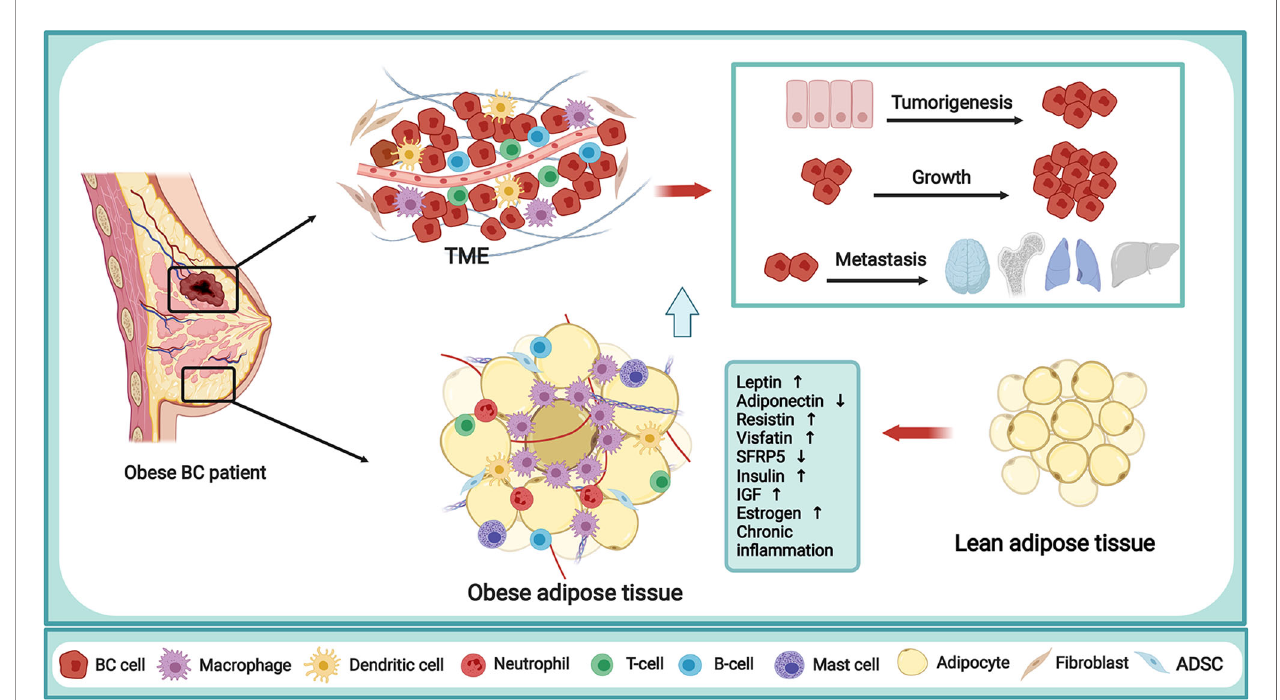
FIGURE 1 | Mechanism of obesity in fueling breast cancer. Obesity is a complex abnormal state, accompanied by various alterations capable of regulating the behavior of BC cells and TME. The obese adipose tissue in BC patient is directly related to the secretion of multiple adipokines, increased levels of insulin, IGF and endogenous sex hormone, and the chronic in fl ammation state, thus creating a TME that encourages tumorigenesis, growth and metastasis of BC. BC, breast cancer; TME, tumor microenvironment; IGF,insulin-like growth factor; SFRP5, secreted frizzled-related protein 5; ADSC, adipose-derived stem cells. The fi gure was created with